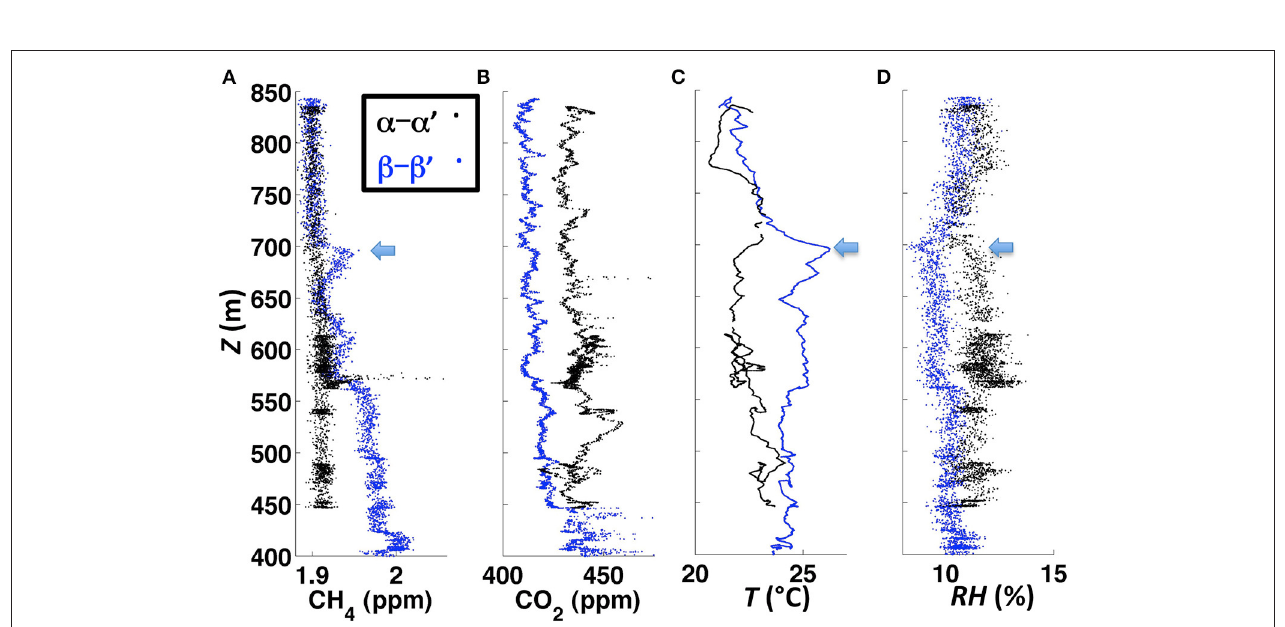
FIGURE 3 | Methane (CH 4 ) data collected in the San Fernando Valley and up into the San Gabriel Mountains to collect atmospheric vertical profile information. Red star shows leak location. Data key, vertical profile locations ( α – α ′ is ascent profile, β ′ – β is descent profile), and size scale on figure.